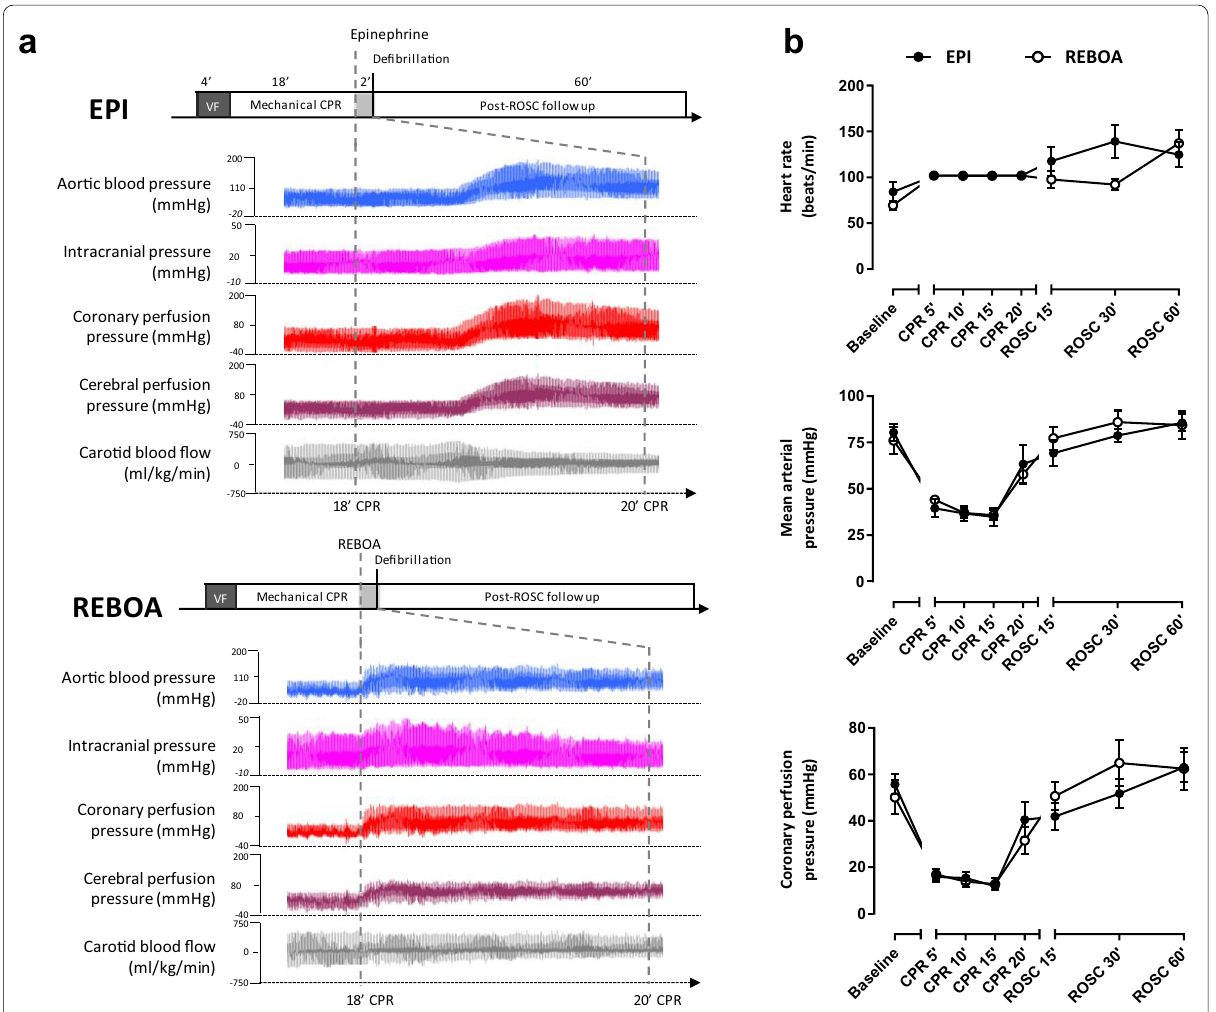
Fig. 1 Typical waveforms of hemodynamic parameters, heart rate, mean arterial and coronary perfusion pressure. a Experimental protocol and typical hemodynamic tracings in two animals before and after either epinephrine (EPI, upper panel) administration or resuscitative endovascular balloon occlusion of the aorta (REBOA, lower panel), respectively. b Heart rate, mean arterial pressure and coronary perfusion pressure during the protocol (i.e., at baseline, during CPR and after ROSC). N 6 in both groups; CPR, cardiopulmonary resuscitation; ROSC, return of spontaneous =